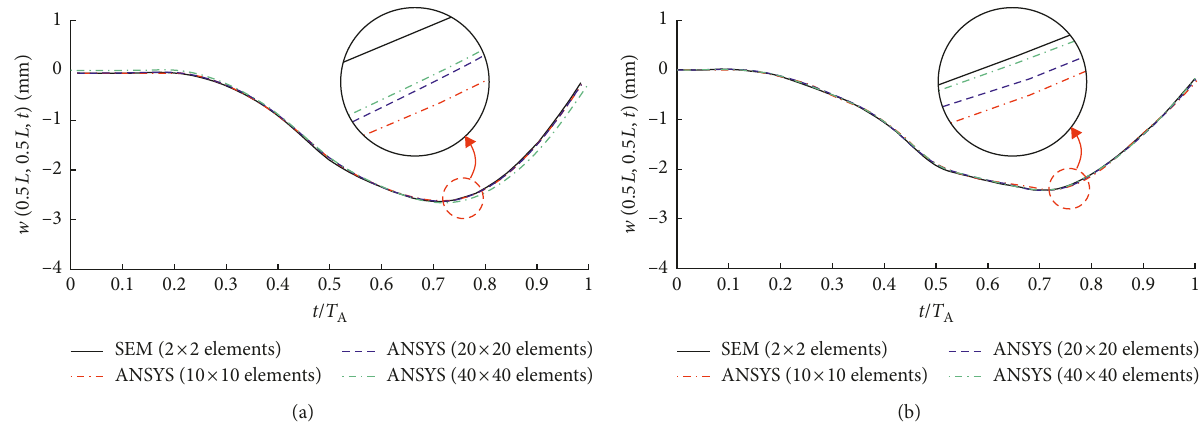
Figure 14: Comparison of the vibration responses obtained by the ANSYS [39] and SEM at the center of the S-S-S-S square plate (Example 1) subjected to a moving point force whose trajectory is given by (a) Case 2 of (39), where v 0